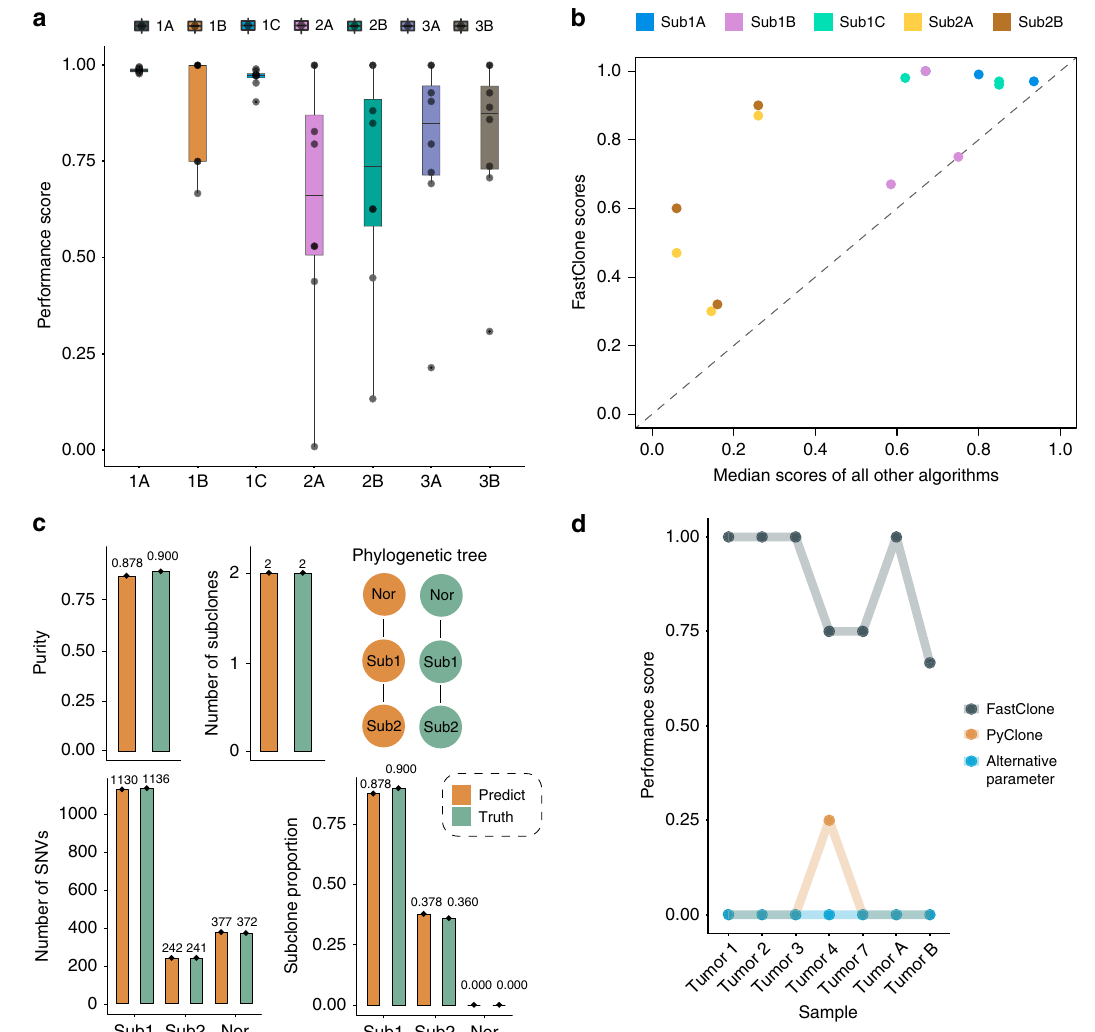
Fig. 3 FastClone ’ s performance on simulated data in DREAM challenge. a Evaluation of prediction accuracy for 1A. Tumor purity, 1B. Number of subclones, 1C. Proportion of each subclone, 2A. Binary assignment of SNVs, 2B. Confusion matrix of co-occurrence of two SNVs in a subclone, 3A. Phylogeny tree, 3B. Tree relationship of individual SNVs. In the boxplots, black dots refer to each tumor sample, center lines refer to median performance, bounds of box refer to the fi rst quartile and the third quartile of the data, and whiskers refer to min and max of the data. b Comparison of FastClone performance with other algorithms. Median scores of other algorithms are calculated from all entries of other teams on the leaderboard of each sub- challenge. Sub3A and Sub3B are not included in this comparison because there are no other entries on the leaderboard. c Example of inferred tumor heterogeneity versus ground truth. “ Sub ” refers to subclones and “ Nor ” refers to normal cell infusion. d The performance scores of FastClone and PyClone on predicting subclone numbers.